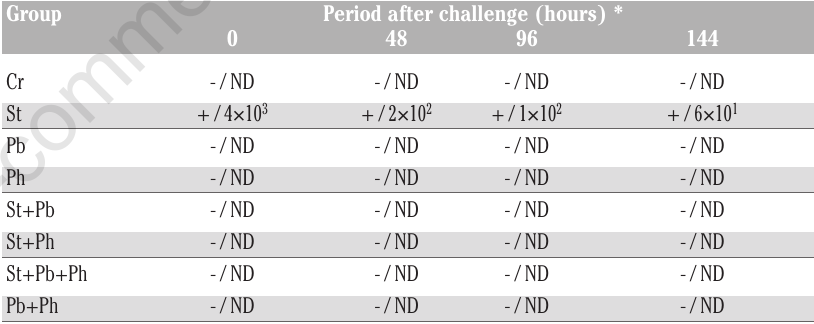
Table 2. Detection of Salmonella Typhimurium in caecum using PCR and conventional bacterial isolation (CFU) in the different treatments. Group